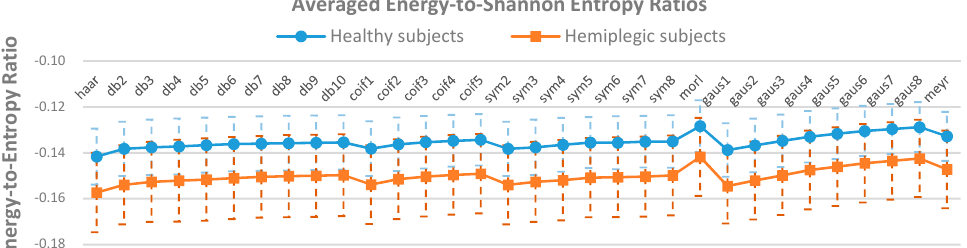
Figure 9. Averaged energy-to-Shannon entropy ratios of CWT coefficients for healthy subjects (blue line) and hemiplegic subjects (red line) across different mother wavelets ( p > 0.05). Vertical dotted line indicates the standard deviation.